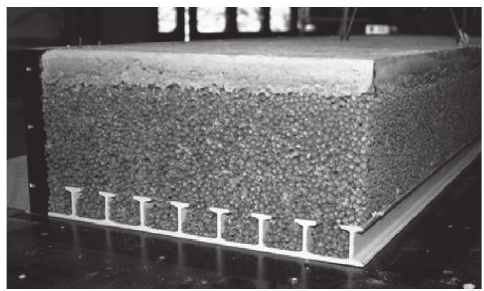
Figure 4: Hybrid FRP-LC deck proposed by Keller.